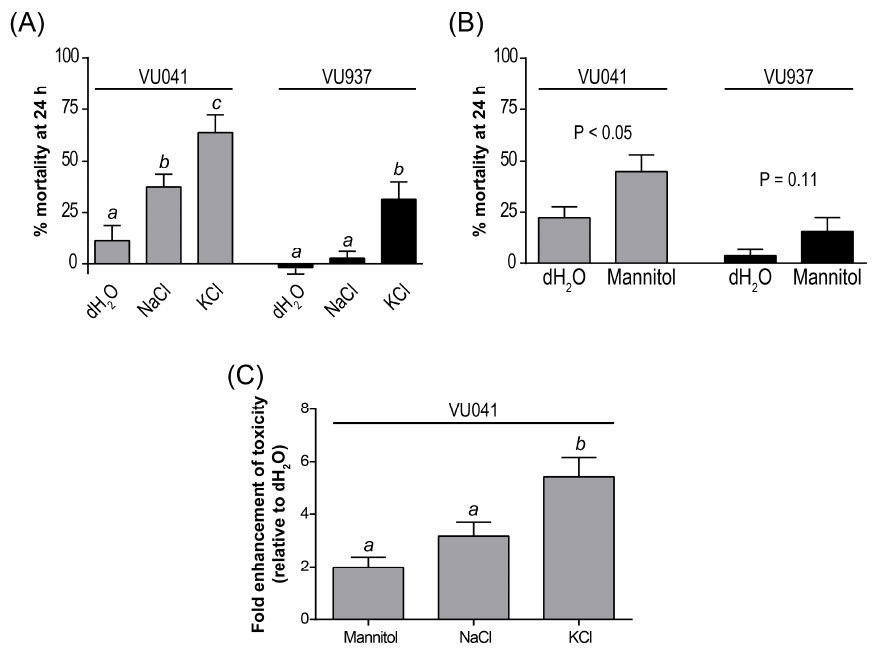
Figure 3. ( A ) Effects of adding 50 mM NaCl or KCl to the rearing water on the 24 h toxicity of VU041 and VU937 in first instar Ae. aegypti . Values are means ± SEM based on 12 replicates of six larvae each for dH 2 O, NaCl, and KCl. Abbott’s correction [31] was applied to the percent mortalities to account for differences in the DMSO control mortality among the dH 2 O, NaCl, and KCl treatments; the mean ± SEM percent mortalities of 1% DMSO in dH 2 O, NaCl, and KCl were 7.1 ± 2.5%, 5.6 ± 3.1%, and 22.8 ± 5.3%, respectively. Lower-case letters indicate statistical categorization of the means within each small molecule treatment as determined by a one-way ANOVA with a Tukey’s multiple comparisons test ( p < 0.05). ( B ) Effects of adding 100 mM mannitol to the rearing water on the 24 h toxicity of VU041 and VU937 in first instar Ae. aegypti . Values are means ± SEM based on 18 replicates of six larvae each for dH 2 O and mannitol. Abbott’s correction [31] was applied to the percent mortalities to account for differences in the DMSO control mortality between the dH 2 O and mannitol treatments; the mean ± SEM percent mortalities of 1% DMSO in dH 2 O and mannitol were 0.9 ± 0.9% and 6.5 ± 2.4%, respectively. p values are from unpaired t -tests comparing mean percent mortalities between dH 2 O and mannitol for each small molecule. The difference was considered significant if p < 0.05. ( C ) Relative enhancement of 24 h VU041 toxicity by mannitol, NaCl, or KCl. Values are means ± SEM based on the data in panels (A,C). Lower-case letters indicate statistical categorization of the means as determined by a one-way ANOVA with a Tukey’s multiple comparisons test ( p < 0.05).